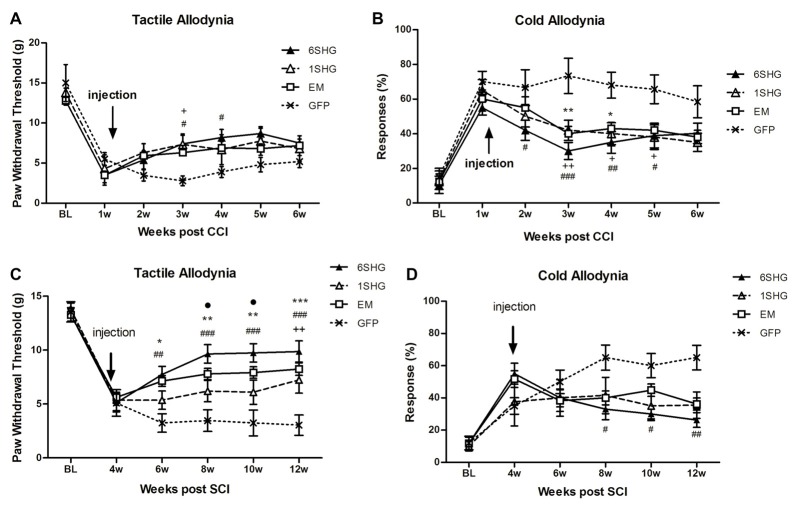
Analgesic effect of individual gene constructs in chronic constriction injury (CCI) (A,B) and spinal cord injury (SCI) (C,D) animals. (A) Injection of 1SHG and 6SHG constructs attenuated tactile allodynia compared to GFP controls at 2 and 3 weeks post injection. (B) Cold allodynia was attenuated in all treated animals compared to GFP control at one through 4 weeks post injection. (C) Stronger analgesic effect of the gene construct was observed in SCI model with attenuation of tactile allodynia in all treated animals up to 8 weeks post injection. (D) Similarly, in cold allodynia test marked drop in cold sensitivity was observed in treated animals (RM ANOVA; +p < 0.05, ++p < 0.01 for 1SHG vs. GFP; #p < 0.05, ##p < 0.01, ###p < 0.001 for 6SHG vs. GFP; *p < 0.05, **p < 0.01, ***p < 0.001 for EM vs. GFP; •p < 0.05 for 6SHG vs. 1SHG).